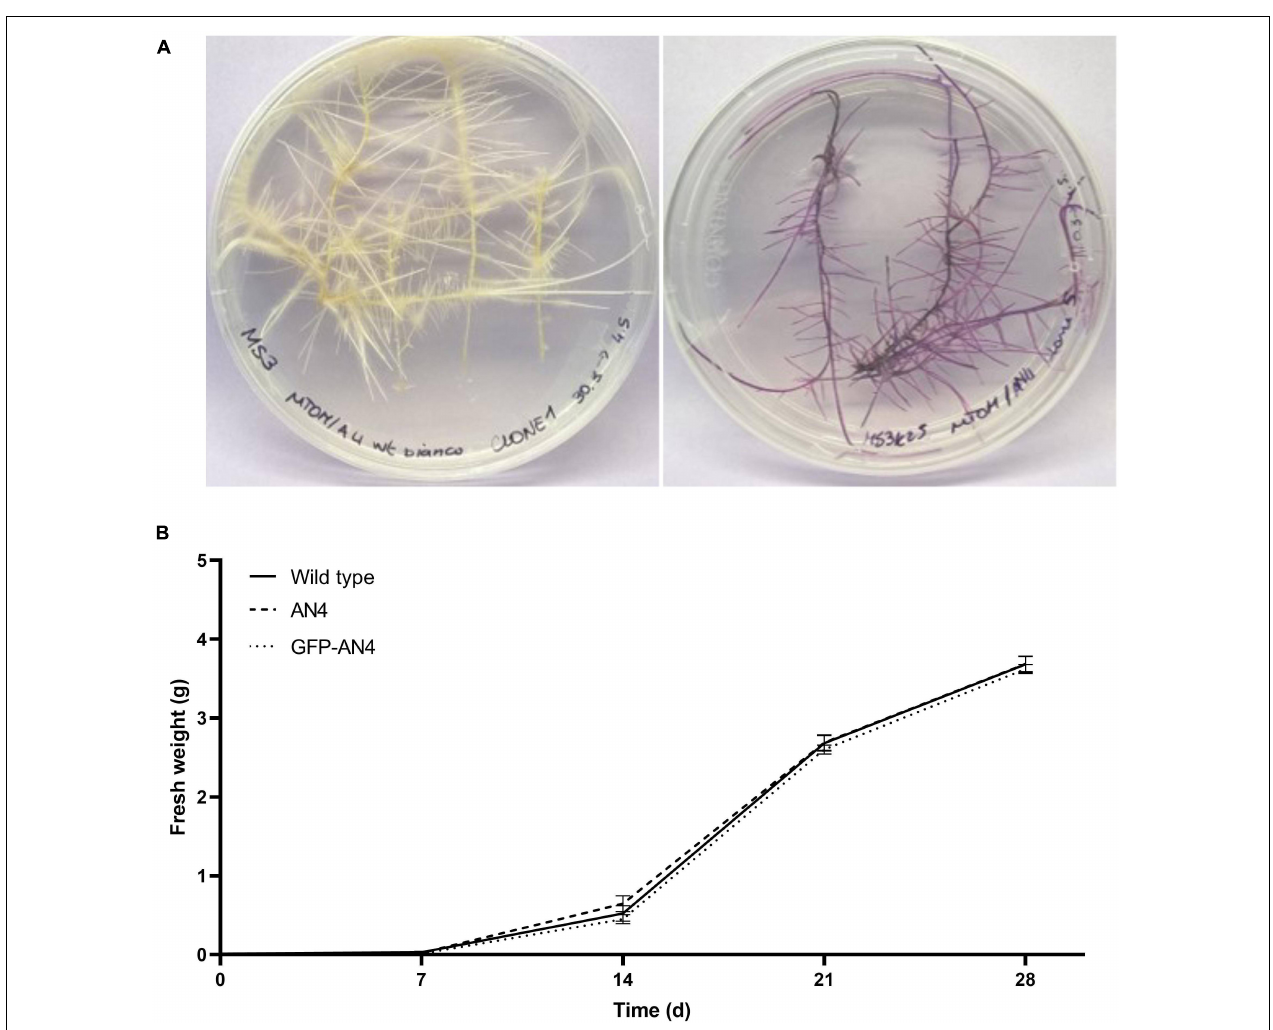
FIGURE 1 | Control (left) and transformed (35S:AN4, right) MicroTom hairy roots (A) . Hairy root culture (HRC) growth estimation by an increase in fresh weight along 28 days of cultures in MS medium (one-way ANOVA analysis of variance with Tukey’s post-hoc test) by GraphPad Prism (B)